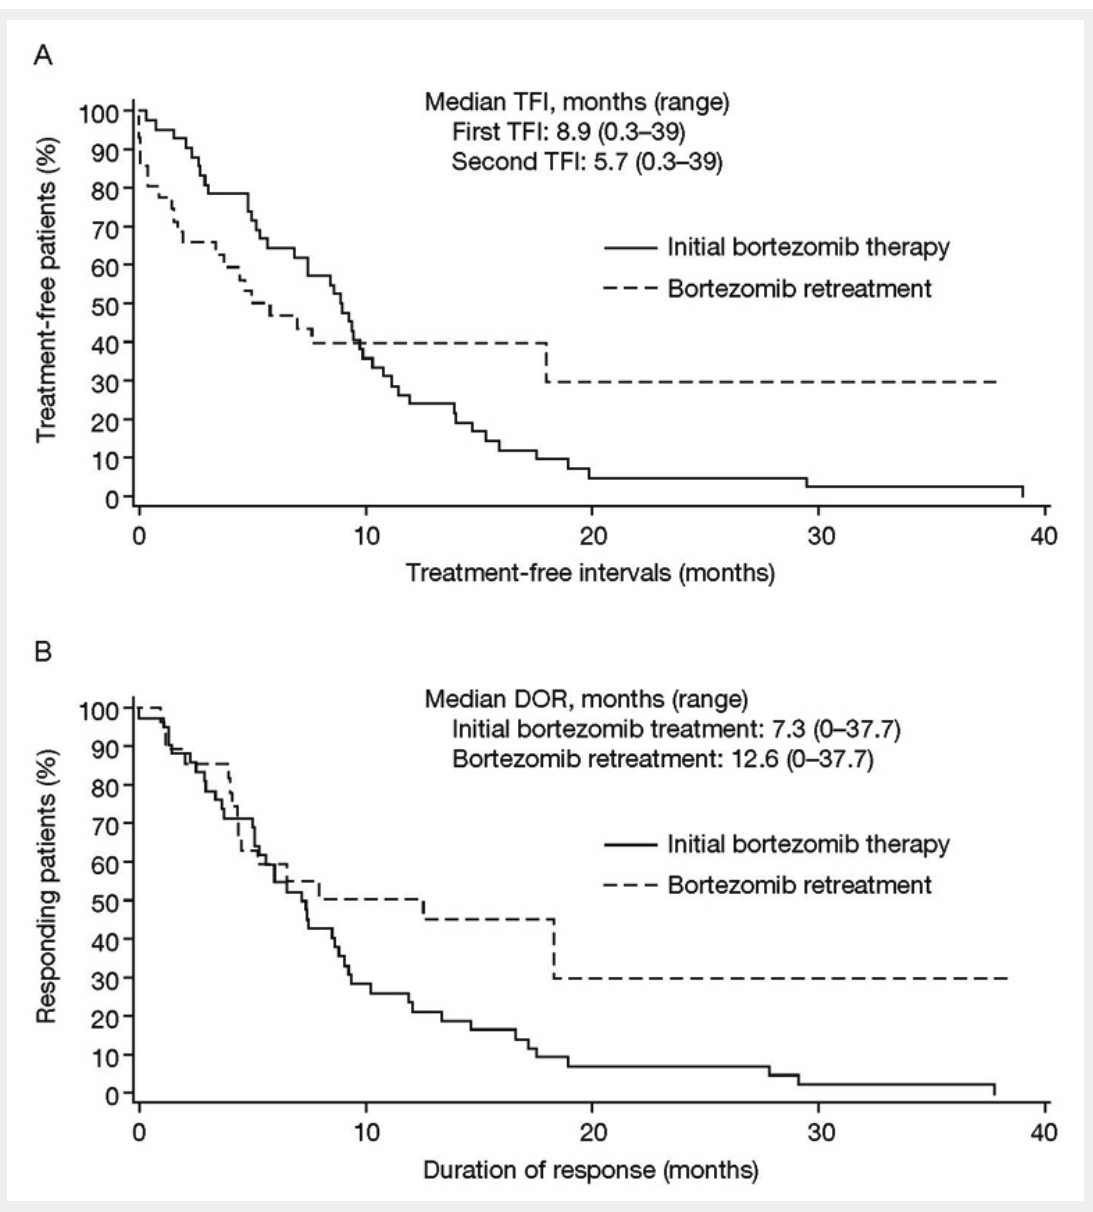
Figure 1 Bortezomib treatment-free interval (A), duration of response